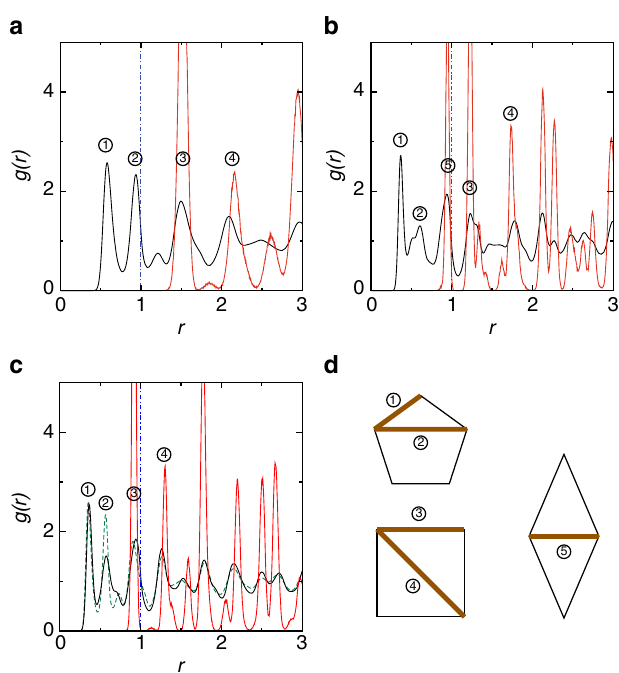
Fig. 3 Comparison of radial distribution functions g ( r ) of QCs for α = 2.0. a – c are for LDDQC, OQC, and HDDQC at ( ρ , T ) = (2.56, 1.53 × 10 − 3 ), (6.60, 1.36 × 10 − 3 ), and (7.00, 1.72 × 10 − 3 ), respectively. The black and red solid curves are calculated based on particles and centers of pentagons, respectively. Note that the major peaks of the red curves match well with those of the black curves. The green dashed curve in c is g ( r ) of LDDQC after r is divided by (7.00/2.56) 1/2 ≈ 1.6536, which shows identical peaks to g ( r ) of HDDQC. The vertical dot – dashed lines mark the location of the potential cutoff at r = 1. d Schematic plots of the characteristic length scales in QCs. The pentagon sketches the basic structural element formed by fi ve particles. The square and rhombus sketch the polygons in the square – triangle and square – rhombus tilings by connecting centers of pentagons. The numbers 1 – 5 denote the side length of pentagons, diagonal length of pentagons, side length of squares, diagonal length of squares, and shorter diagonal length of rhombi, respectively. Note that in the tilings the equilateral triangles and rhombi have the same side length as the squares, so length no. 3 actually represents the side length of all polygons in the tilings. In a – c , we number the peaks corresponding to the length